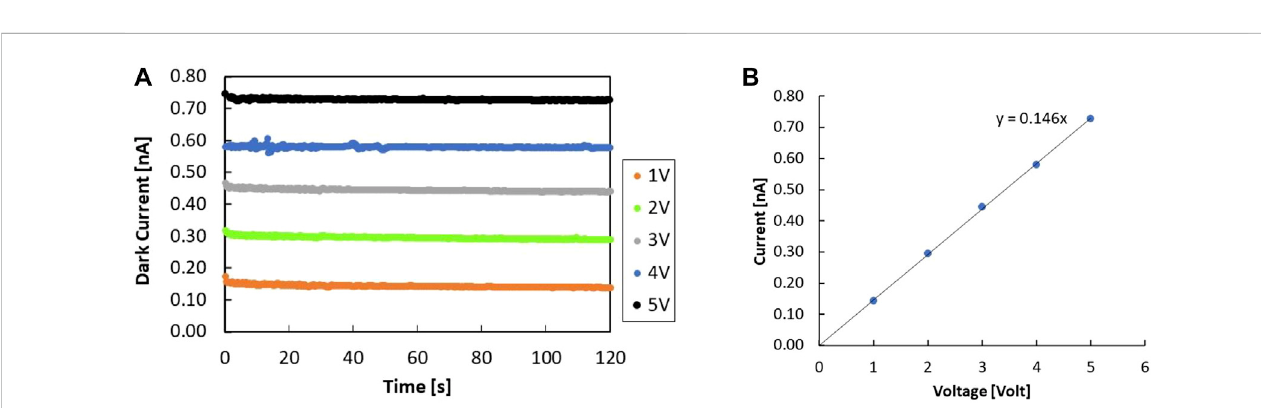
FIGURE 4 (A) Darkcurrentofthe1 μ m-thickCsPbCl 3 fi lmdepositedonPdIDEsasafunctionoftimemeasuredatroomtemperatureanddifferentappliedvoltages. (B) Average currents plotted as a function of the voltage, with linear best fi